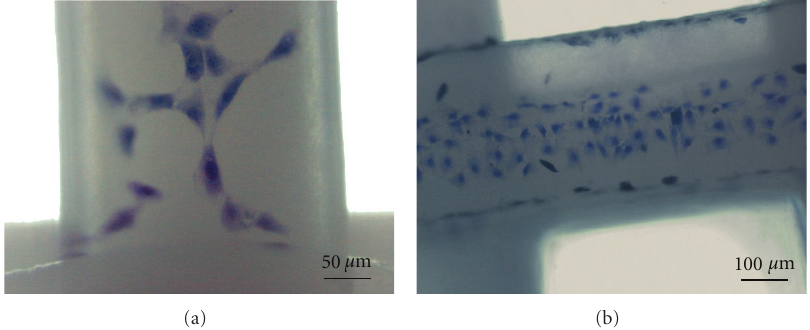
Figure 8: Bright field micrographs of mouse embryo fibroblasts stained with toluidine blue after six days of culture onto PCL sca ff olds.